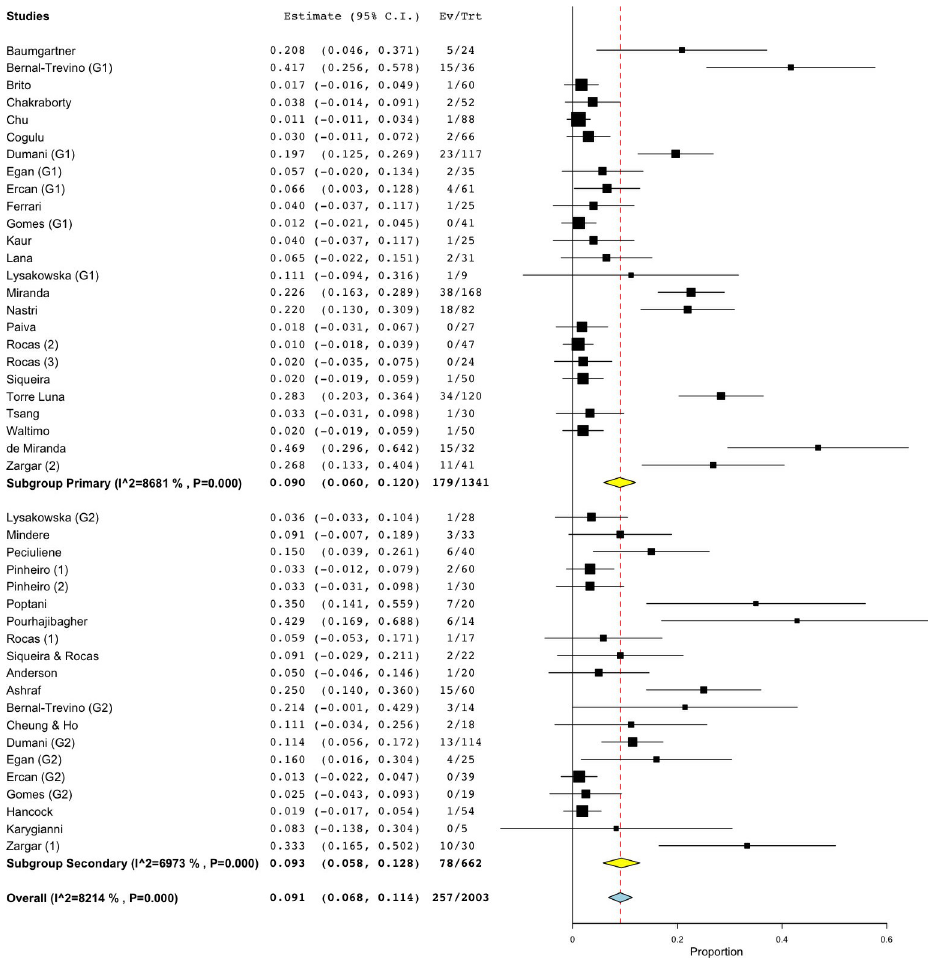
Fig 2. Forest plot representing fungal species prevalence in included studies, distinguishing primary or persistent